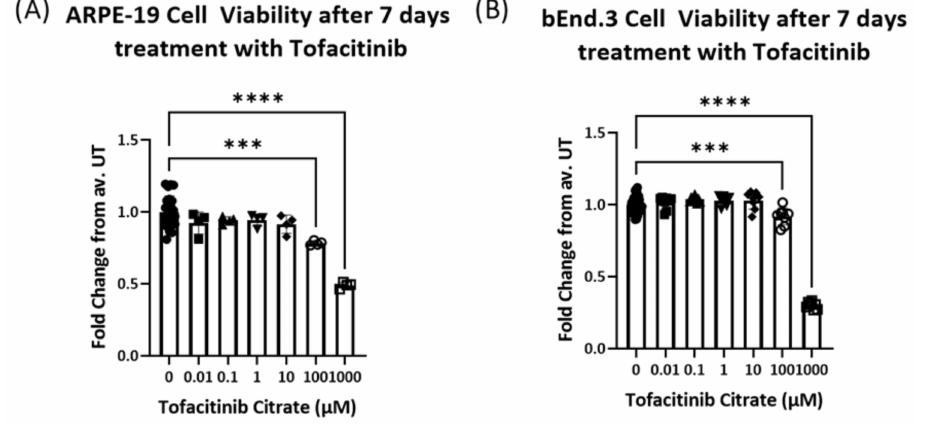
Figure A6. The effect of Tofacitinib Citrate on the viability of ARPE19 and bEnd.3 cells. The ARPE19 or bEnd.3 cells were treated with different concentrations of Tofacitinib for 7 days. Cell viability was evaluated by using the Alamar blue assay. ( A ) Viability fold change in ARPE-19 cells. ( B ) Viability fold change in bEnd.3 cells. *** p ≤ 0.0005, **** p ≤ 0.0001. One-Way ANOVA and Dunnett’s multiple comparisons